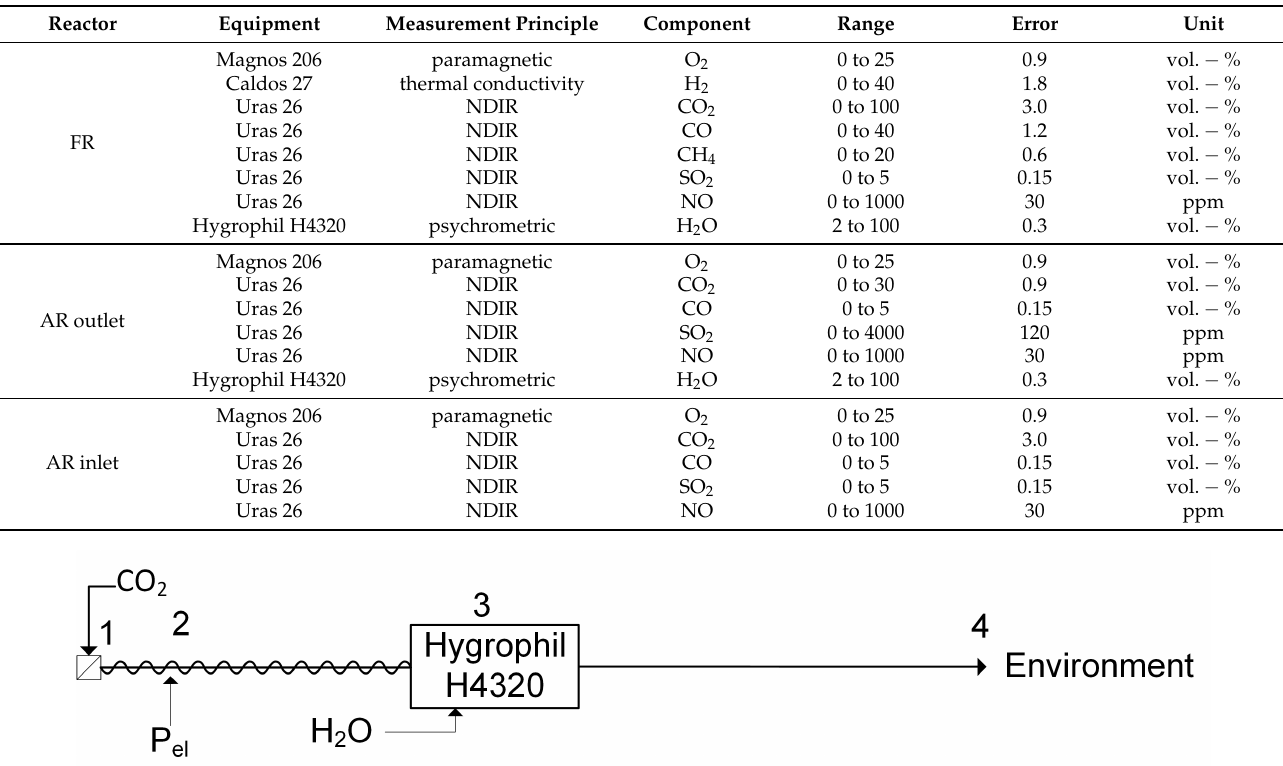
Figure 7. Schematic of the water content analysis equipment: (1) heated probe with filter, (2) heated tube, (3) psychrometric analyzer, (4) safe location in the